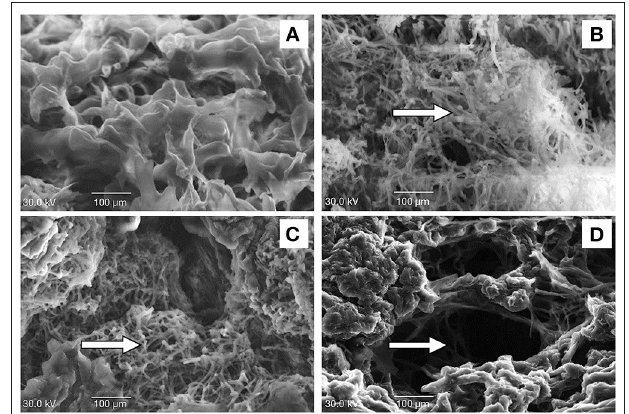
FIGURE 2 | Effect of UV-C treatment on cellular structure of albedo tissue in satsuma mandarin fruit; before treatment (A) , untreated control (B) , 3 kJ m − 2 (C) , and 10 kJ m − 2 UV-C (D) groups. The arrows indicate mycelium and spores of P. digitatum